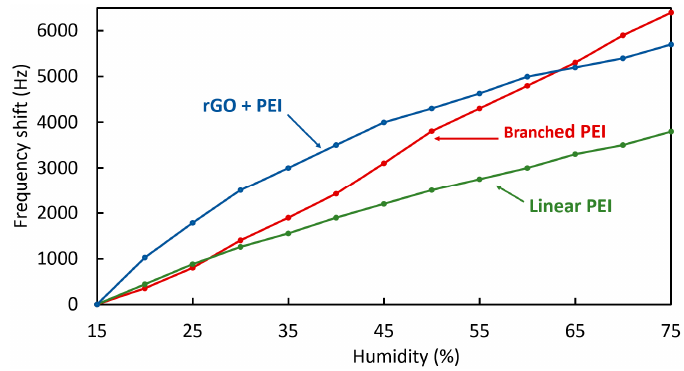
Figure 16. Frequency shift of the coatings at different range of air humidity from 15 to 75